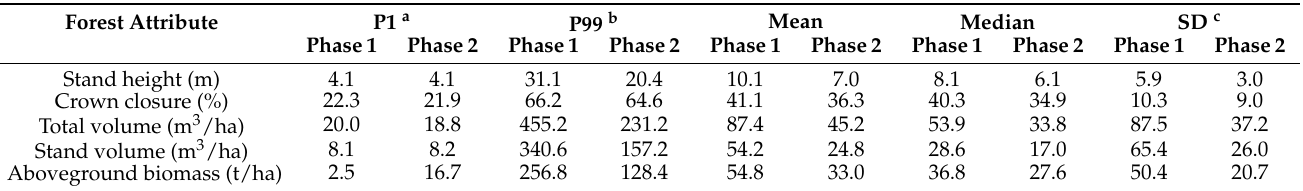
Table 8. Descriptive statistics for the surrogate plots used for k-NN estimation by